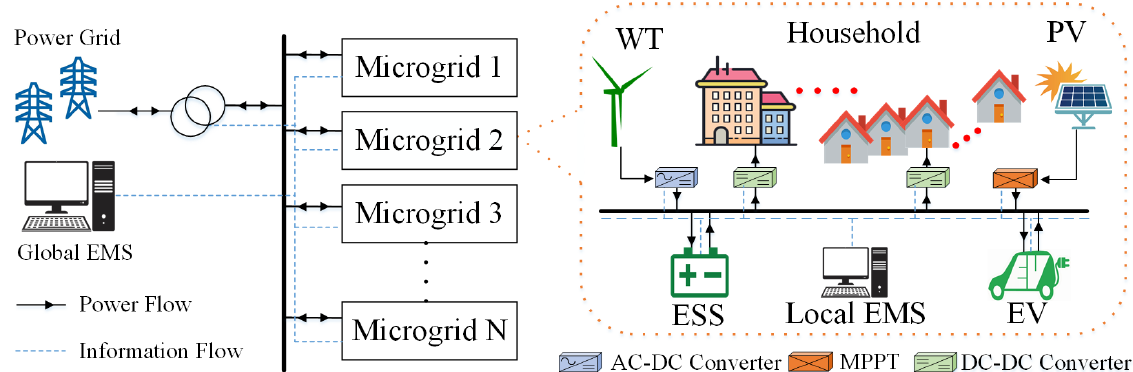
Figure 2. A schematic diagram of interconnected multi-microgrid